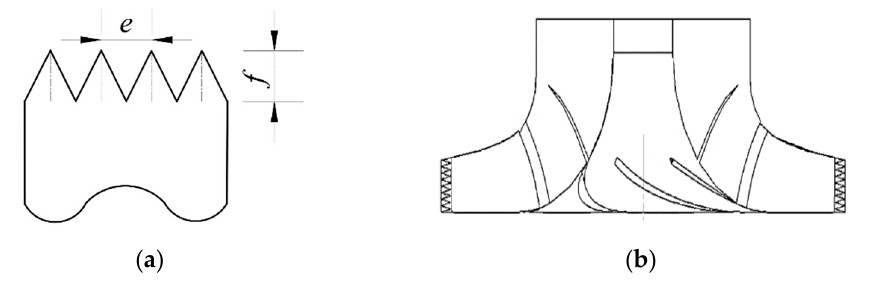
Figure 3. ( a ) Parameters of bionic sawtooth structure; ( b ) calculated domain of bionic sawtooth impeller.